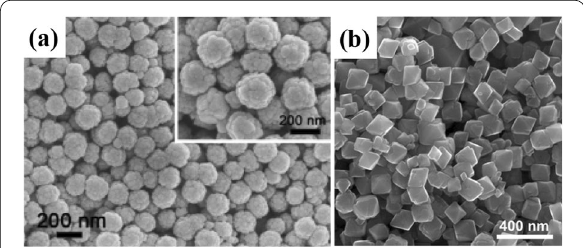
Fig. 10 a SEM images of the Fe 3 O 4 nanospheres synthesized with ethylenediamine (EDA). The inset of ( a ) shows a SEM image with higher magnification. (Reprinted with Permission from [129]. Copyright, American Chemical Society.). Physicochemical characterization of the octahedral Fe 3 O 4 nanoparticles. b SEM image showing the octahedral geometry of the iron oxide nanoparticles. Reprinted with Permission from [130]. Copyright,